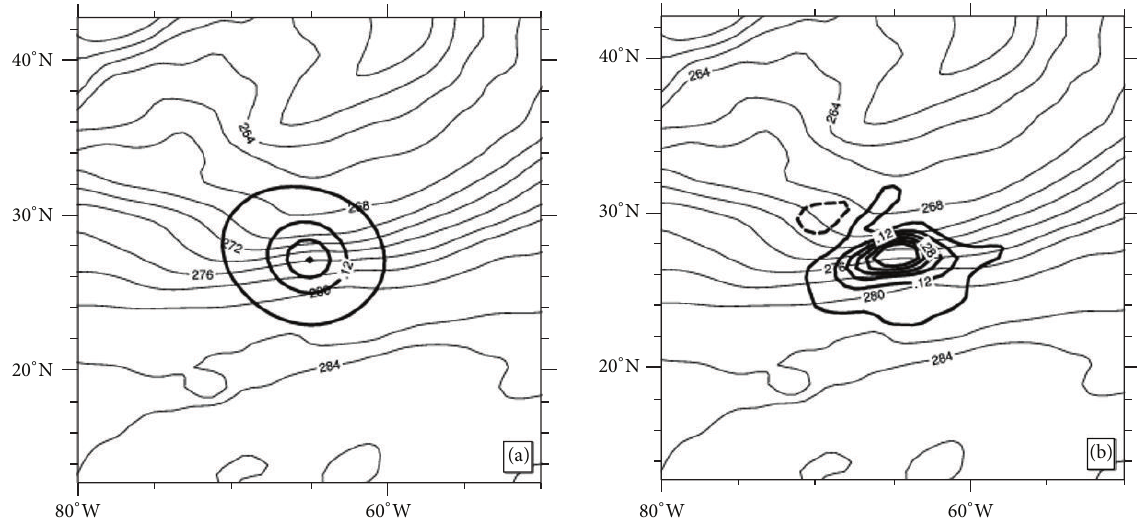
Figure 1: The increments of temperature fields after assimilating a single temperature observation at 700 hPa (shown at black dot in a). The temperature observation was one degree warmer than the background forecast. The thin and thick black contours are the background temperature forecasts and the increments of temperatures at model level 19, respectively. The unit is degrees K. (a) is for GSI3DVar using static covariance and (b) is for the 3DEnsVar with the full ensemble